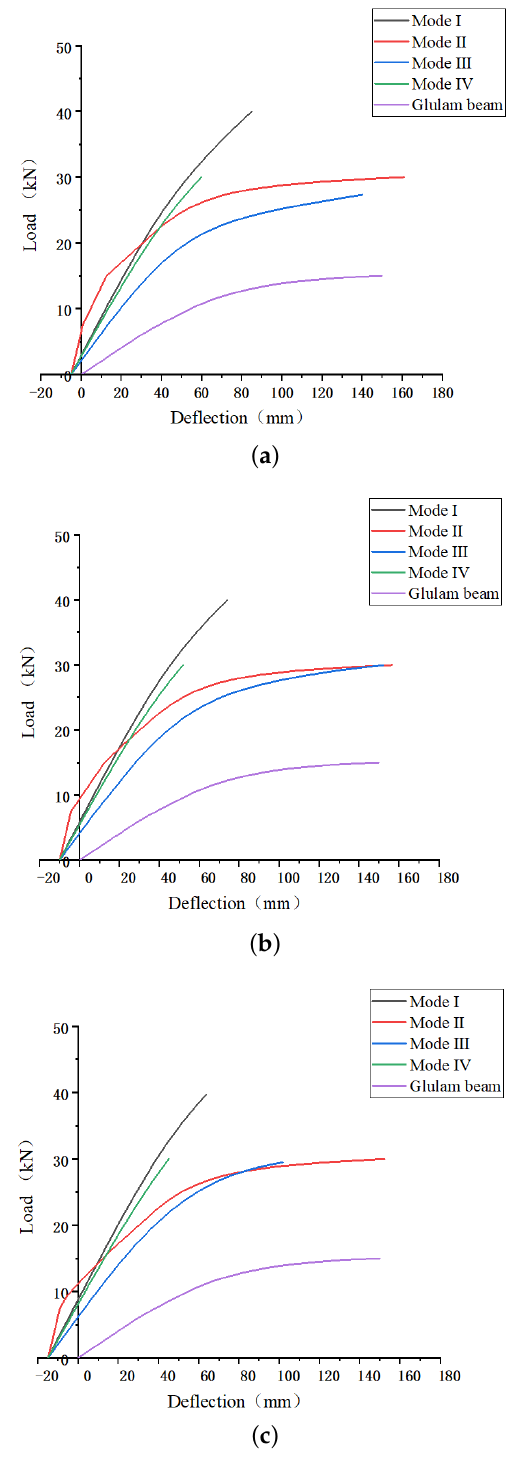
Figure 9. Load-deflection curves with various initial mid-span deflection. ( a ) Five mm initial mid-span deflection, ( b ) 10 mm initial mid-span deflection and ( c ) 15 mm initial mid-span